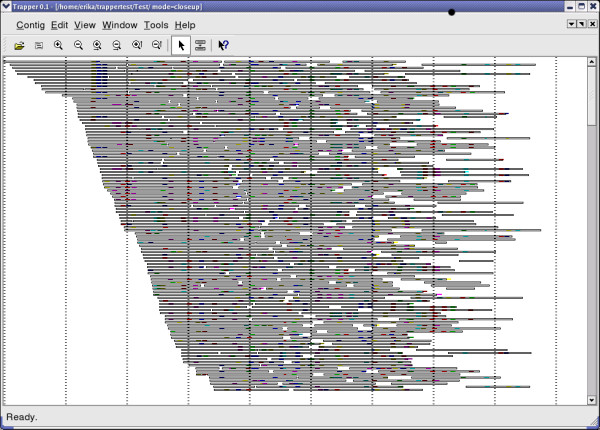
Partial view of an alignment in DNPTrapper. Boxes represent shotgun fragment reads, colored dots represent DNPs. This is a zoomed out view of a simulated dataset after DNP detection. The difference between repeat copies was 2% between any two units. At this zoom level, DNP patterns are visible.